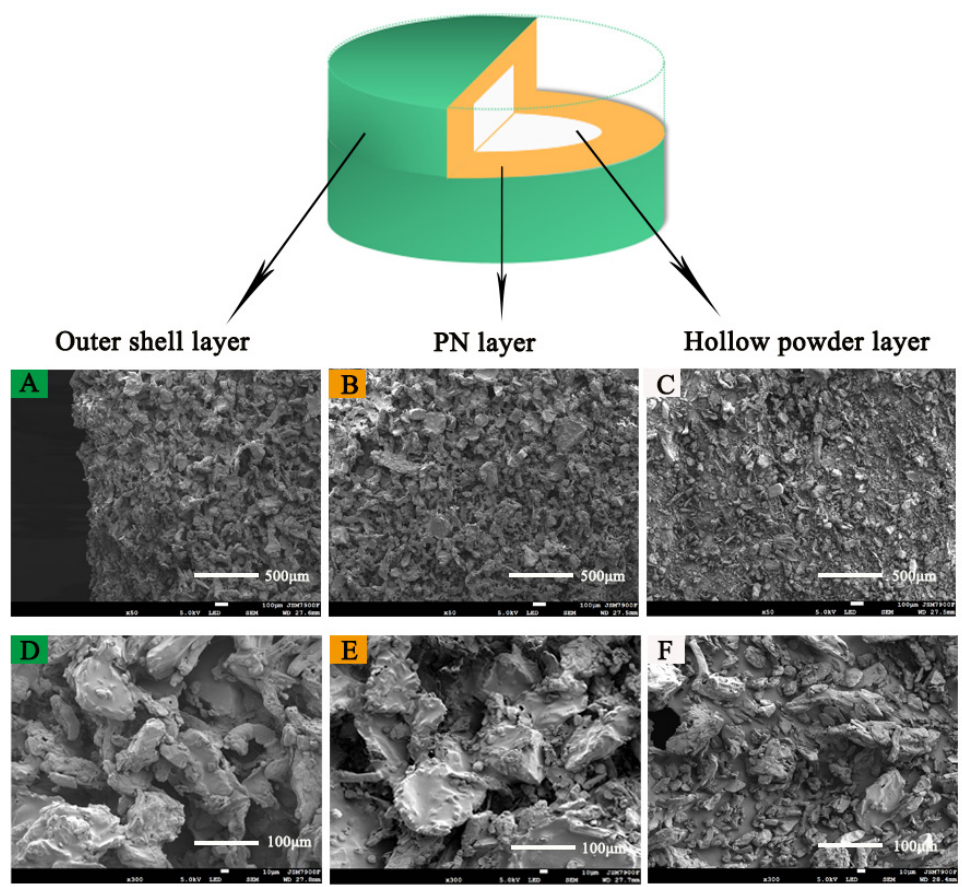
Figure 8. SEM image of the 3D-printed compound multicompartmental structure. ( A ): Outer shell layer (50×); ( B ): PN layer (50×); ( C ): hollow powder layer (50×); ( D ): outer shell layer (300×); ( E ): PN layer (300×); ( F ): hollow powder layer (300×).